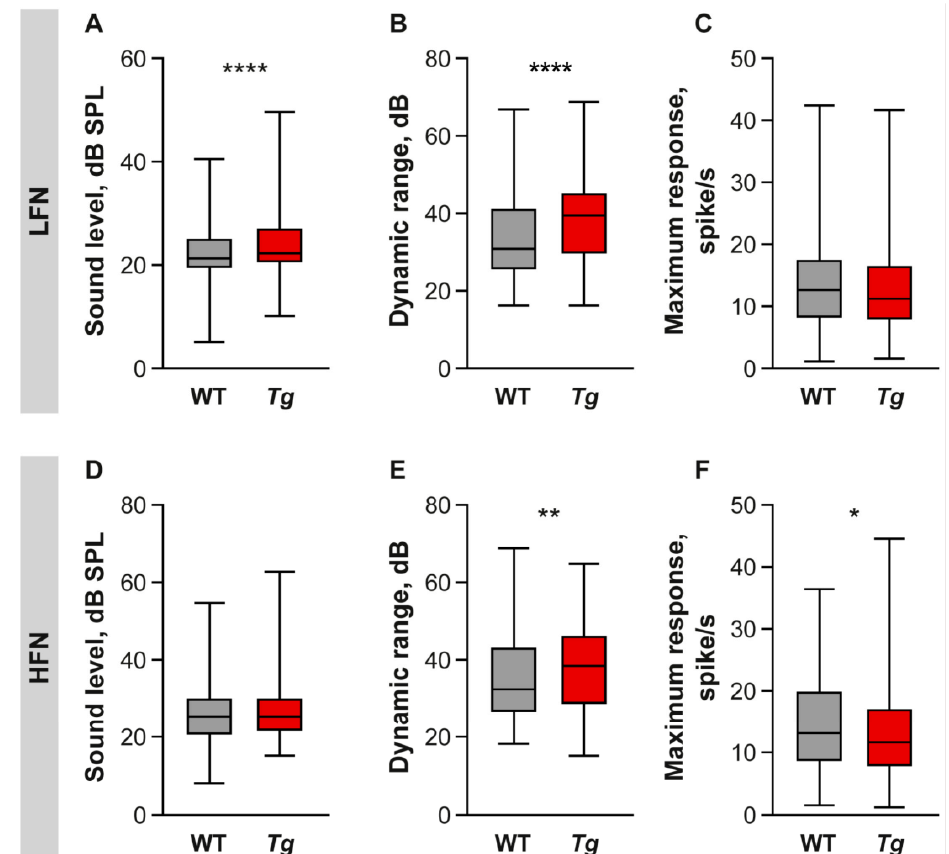
Figure 4. Characteristics of the rate-intensity functions measured using broad-band noise. ( A – F ) Box and whiskers plots depicting distribution of neuronal threshold ( A , D ), dynamic range ( B , E ) and maximum response ( C , F ) values in LFN ( A – C ) and HFN ( D – F ) of WT and Tg mice. Median with interquartile range and extremes, Mann–Whitney test, * p < 0.05, ** p < 0.01, **** p <